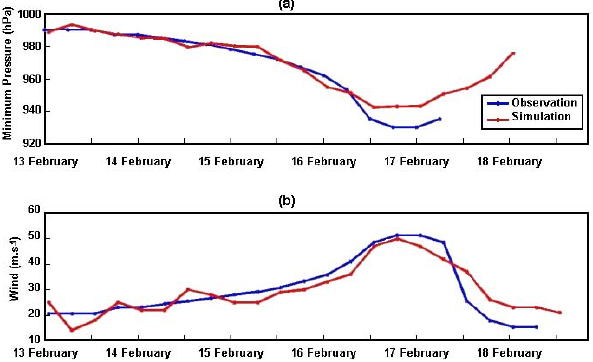
Fig. 3. Time series of (a) the minimum central pressure and (b) the 10min average maximum sustained wind speed from best track data (blue line) and model simulation (red